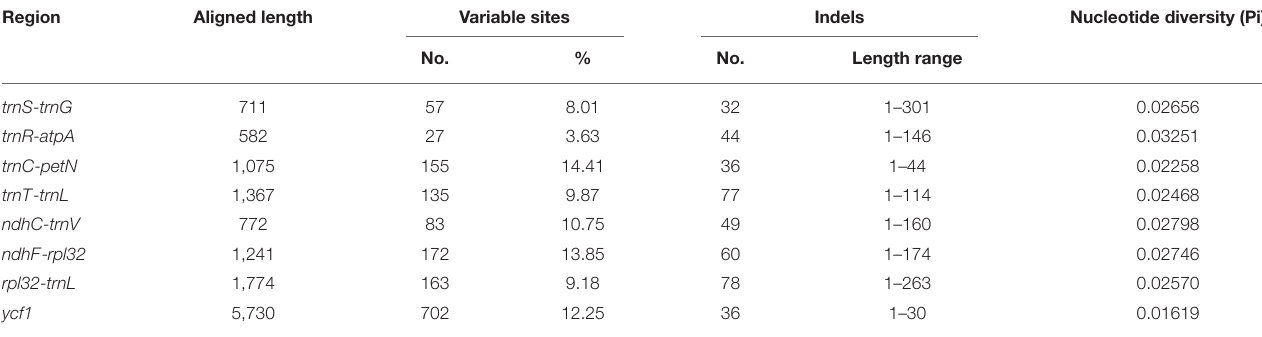
TABLE 4 | Sequence characteristics of eight high variable regions among 22